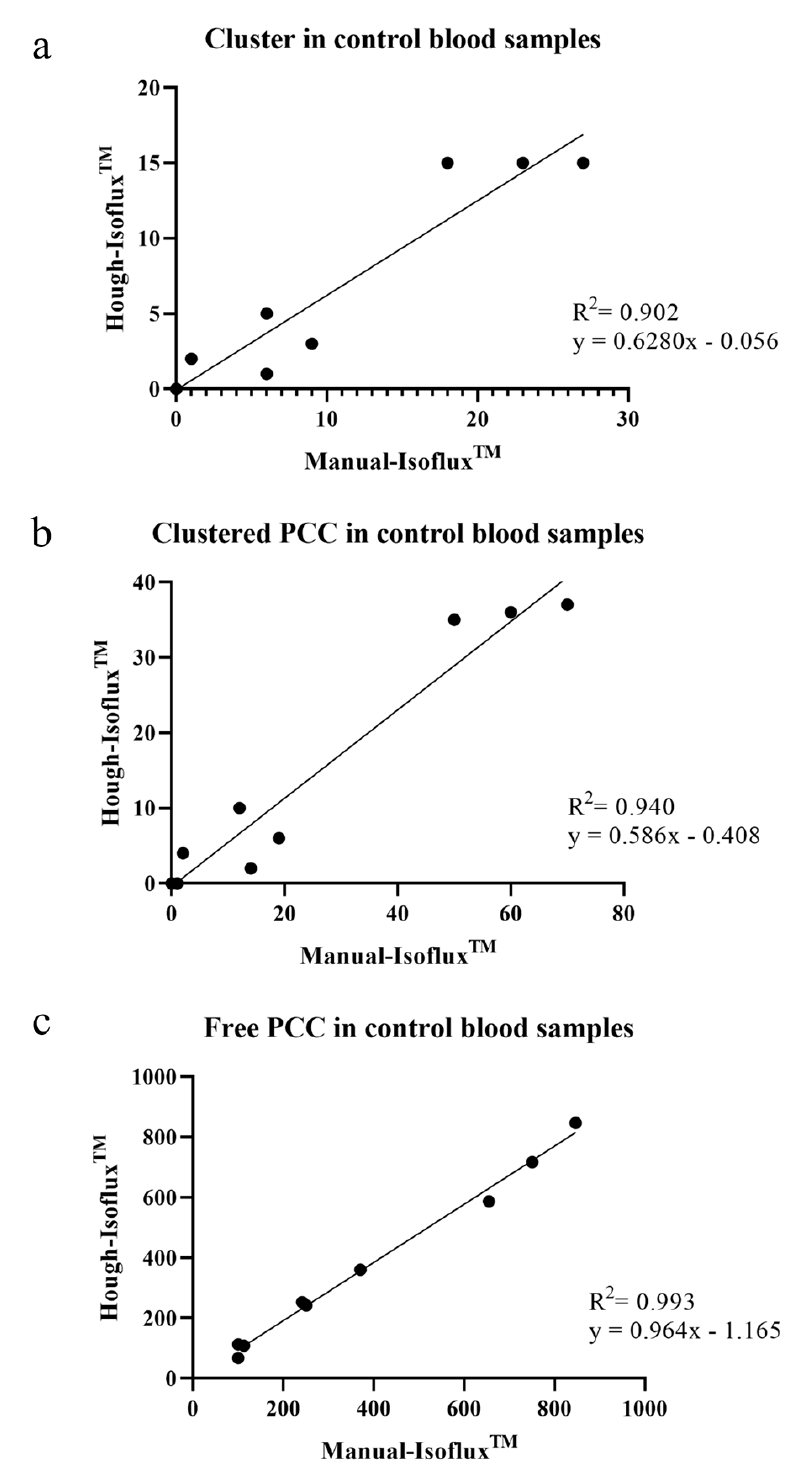
Figure 3. ( a ). Cluster measurement in control blood samples: Manual-Isoflux TM System vs. Hough- Isoflux TM System. ( b ). Clustered-PCC measurement in control blood samples: Manual-Isoflux TM System vs. Hough-Isoflux TM System. ( c ). Free PCC measurement in control blood samples: Manual- Isoflux TM System vs. Hough-Isoflux TM